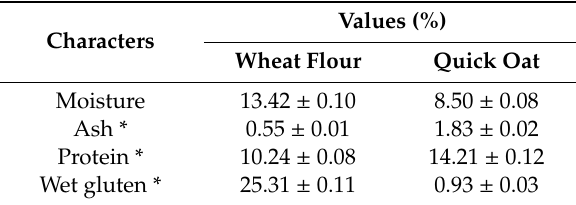
Table 4. Characteristics of wheat